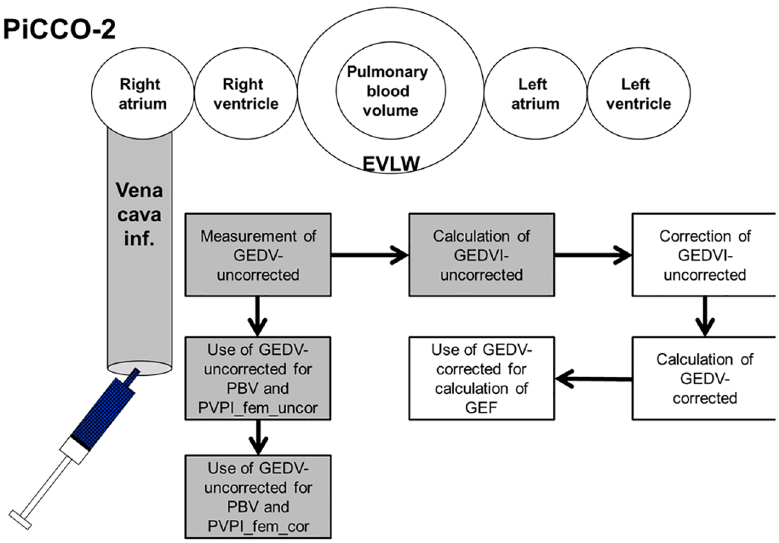
Fig 2. Algorithm for the calculation of GEDV, GEDVI, PBV, PVPI and GEF as displayed by the PiCCO-2 software V 3.1. Confounders (volumeof VCI) and confounded values with marked deviationfrom corresponding measurements using jugularaccess (PBV, PVPI_fem) are shaded. The primarily measured GEDVfem_uncor is indexedto predicted body surface area (BSA) resulting in GEDVI_fem_uncor. In a next step GEDVI_fem_cor is derivedfrom correction of GEDVI_fem_uncor accordingto the previously suggested formula. UnindexedGEDV_fem_cor results from multiplication of GEDVI_fem_cor by predicted BSA and is used for calculationof GEF_fem_cor. By contrast, PVPI_fem is basedon GEDV_fem_uncor irrespective of givingthe informationabout the femoral CVC-position. GEDV(I): globalend-diastolic volume (index) PBV: pulmonary blood volume PVPI: pulmonary vascular permeability index GEF: globalejectionfraction BSA: body surface